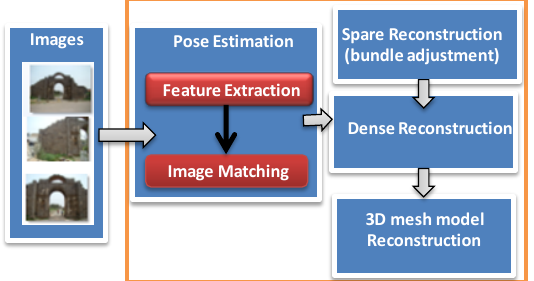
Figure 5. Basic workflow of SfM-based software